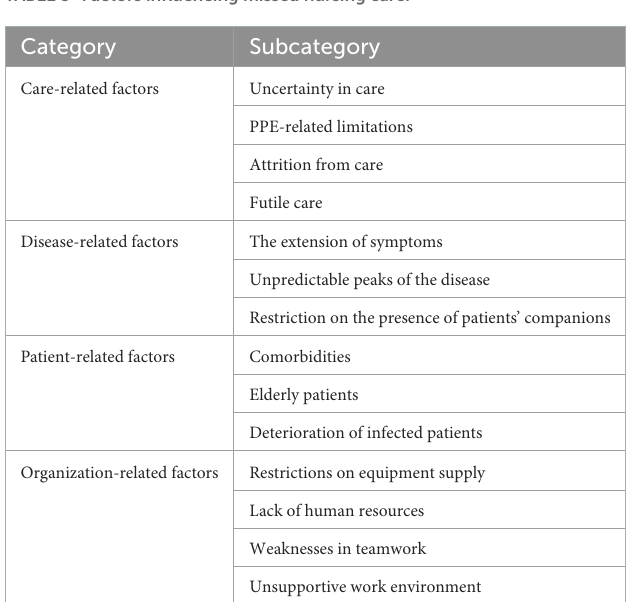
TABLE 5 Factors influencing missed nursing